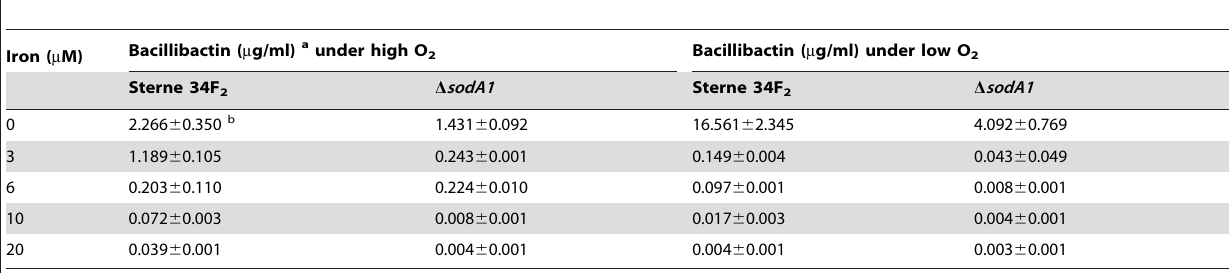
Table 4. Quantification of bacillibactin from IDM cultures of Bacillus anthracis Sterne 34F 2 and D sodA1 with the addition of different concentrations of iron under high (high O 2 ) and low aeration (low O 2 ).